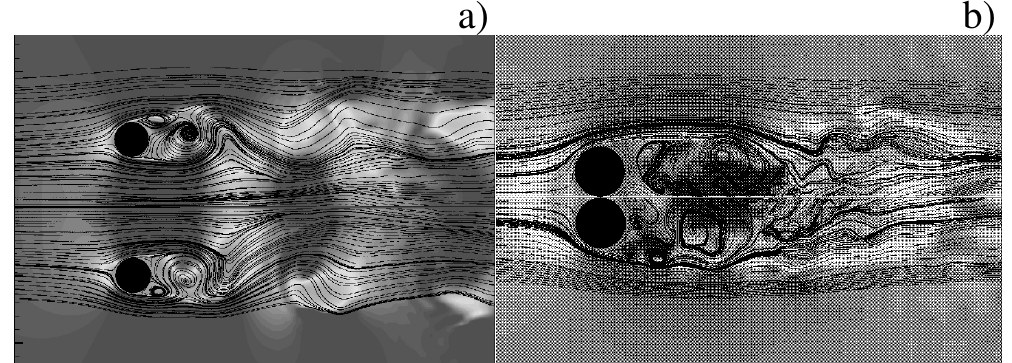
Figure 12. Instantaneous snapshots of streamwise velocity (gray scale) and streamtraces ( ) for the three-dimensional flow around a torus: ( a ) Γ = 0.5, Re = 1000; ( b ) Γ = 2, Re =